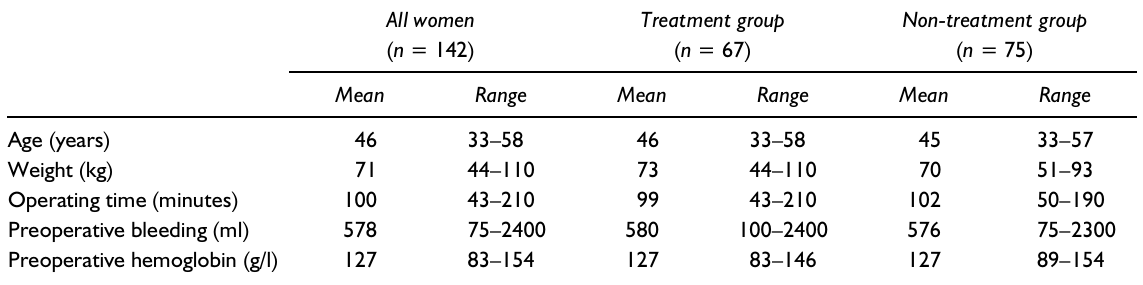
Table 2 Background